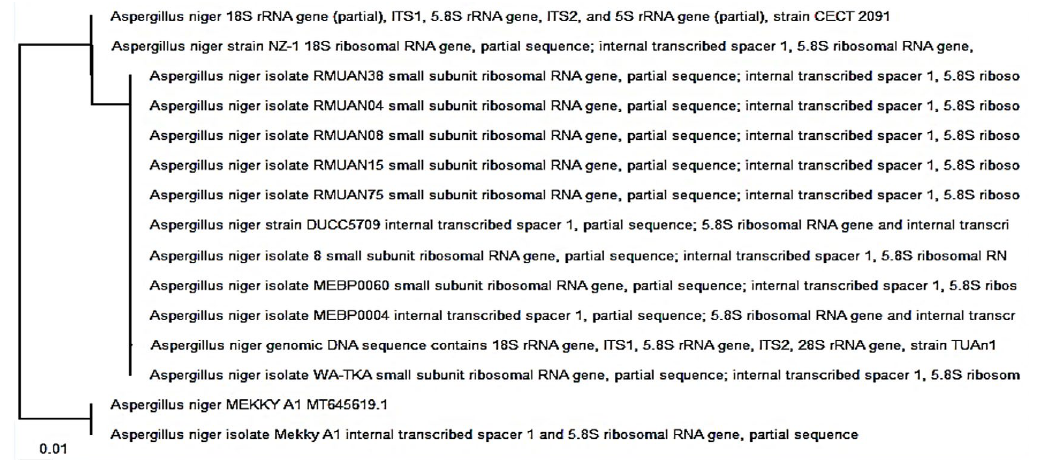
Fig. 2. Phylogenetic tree of gene sequences of the Aspergillus niger isolate with the sequences retrieved from NCB Gene Bank site.